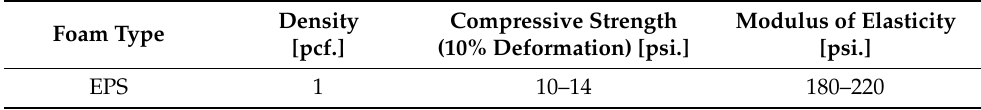
Table 2. Material properties of the EPS foam insulation